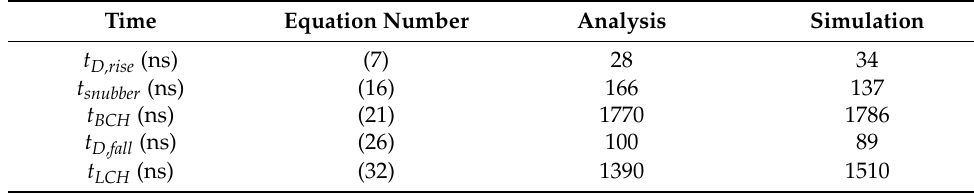
Table 9. Comparison between analysis and simulation result.